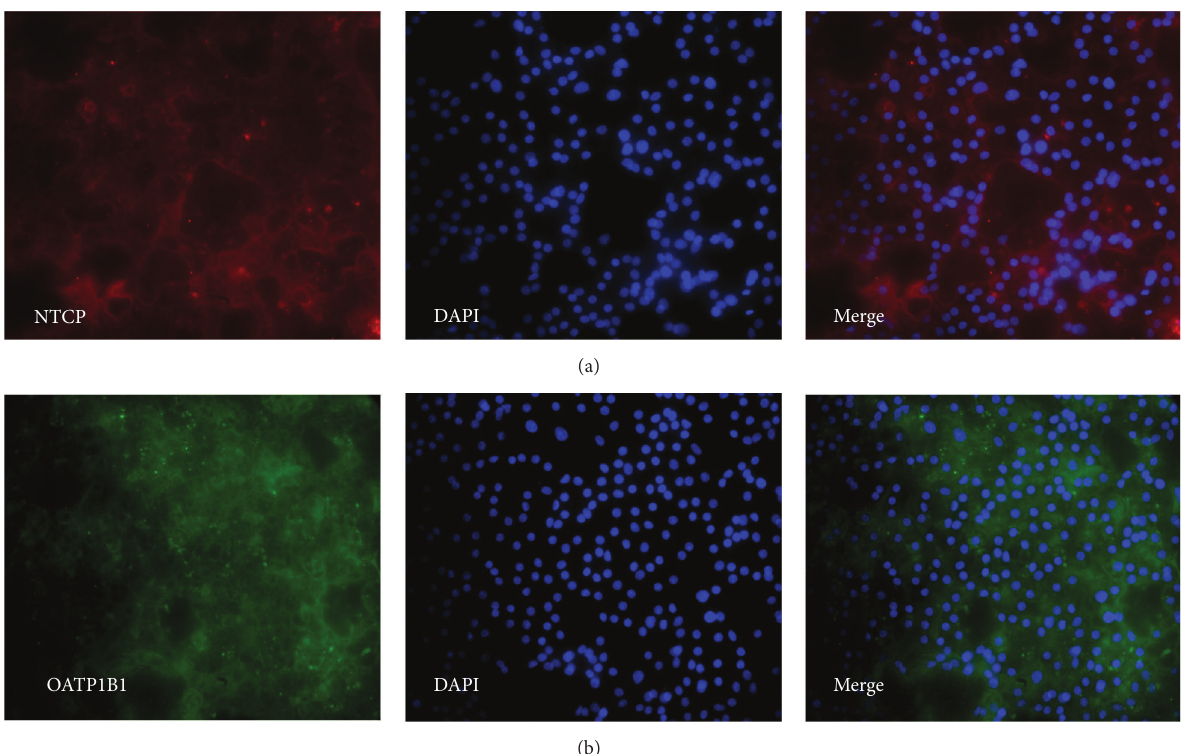
Figure 16: Representative micrographs illustrating the expression of drug transporters at day 29 of the hepatic differentiation of P11012. Magnification: 20x. Panel (a) shows stainings for NTCP. Panel (b) shows stainings for